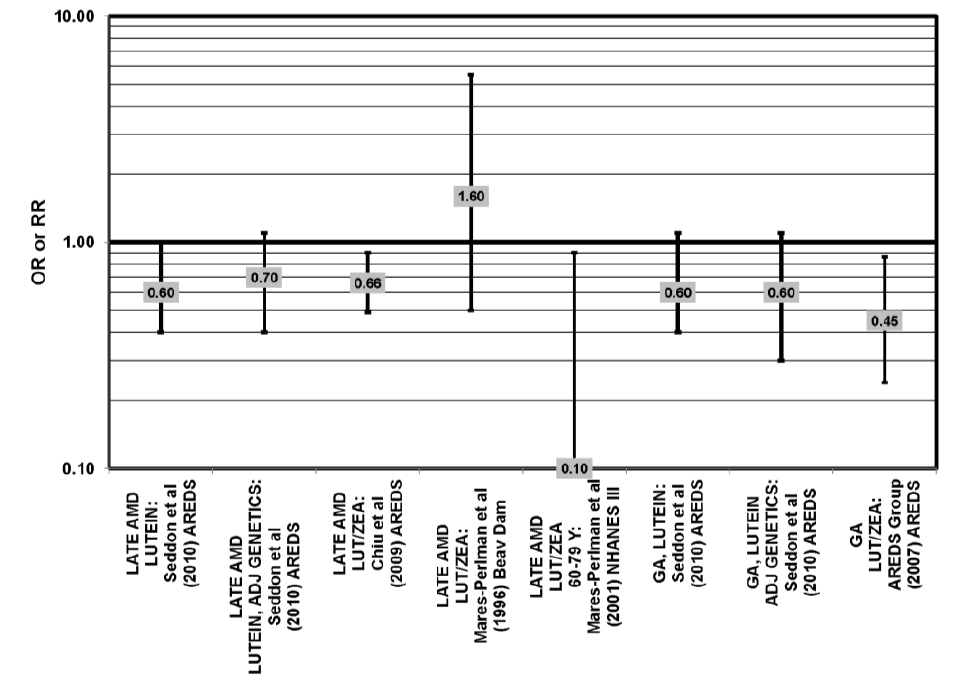
Figure 28. Odds or risk ratio for late AMD or geographic atrophy (GA); high vs. low intake of lutein and zeaxanthin from food: retrospective and cross-sectional studies.